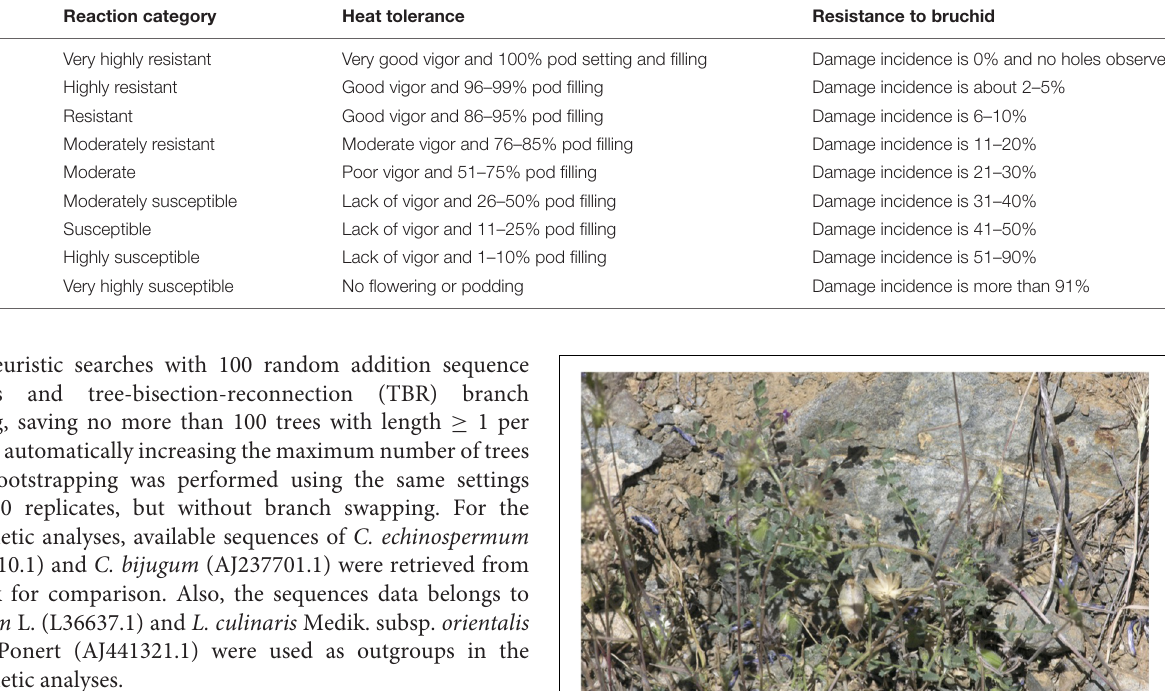
TABLE 2 | A visual quantitative 1–9 scale for resistance to a/biotic stresses evaluated in Exps 1 and 2.